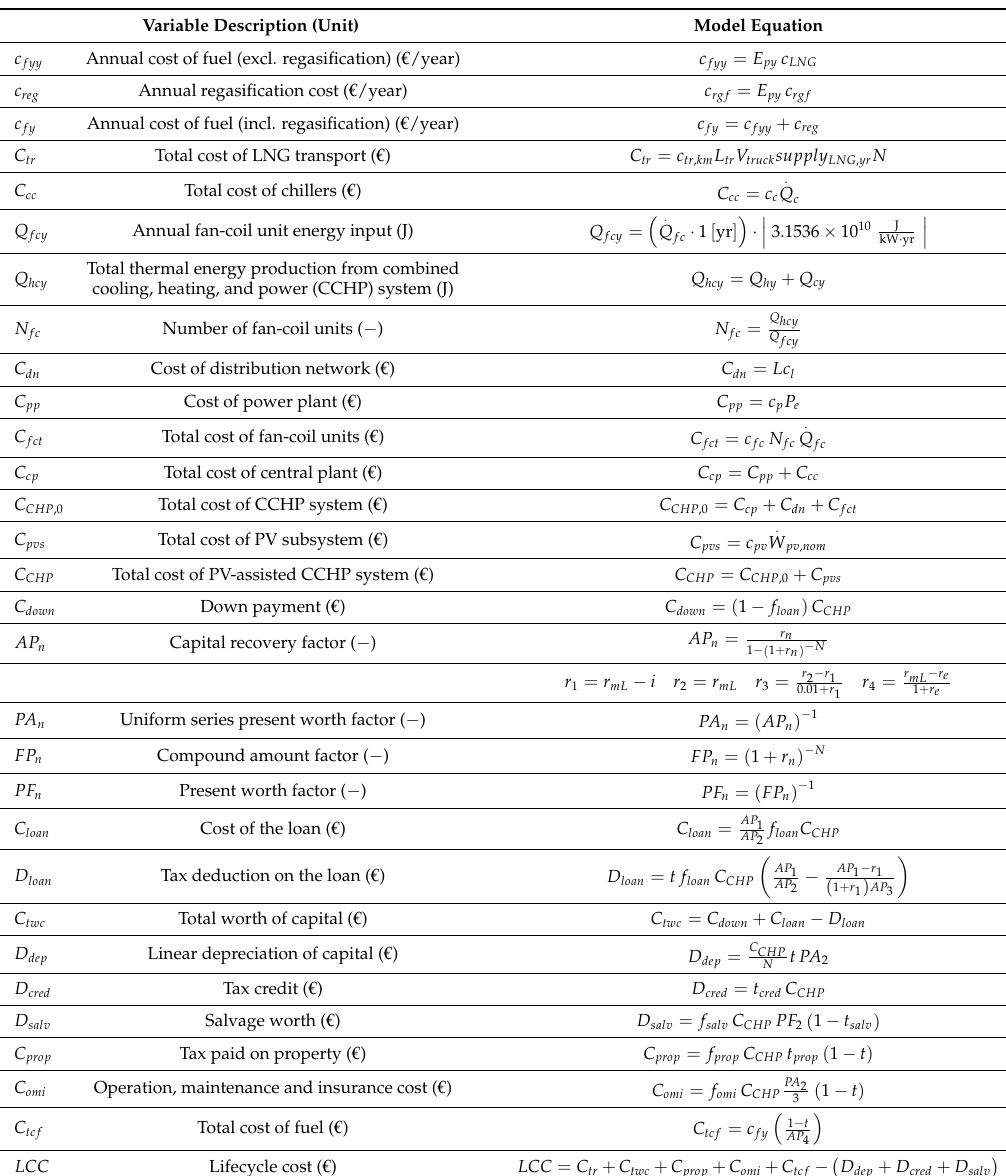
Cost model for the proposed photovoltaic-assisted combined cooling, heating, and power